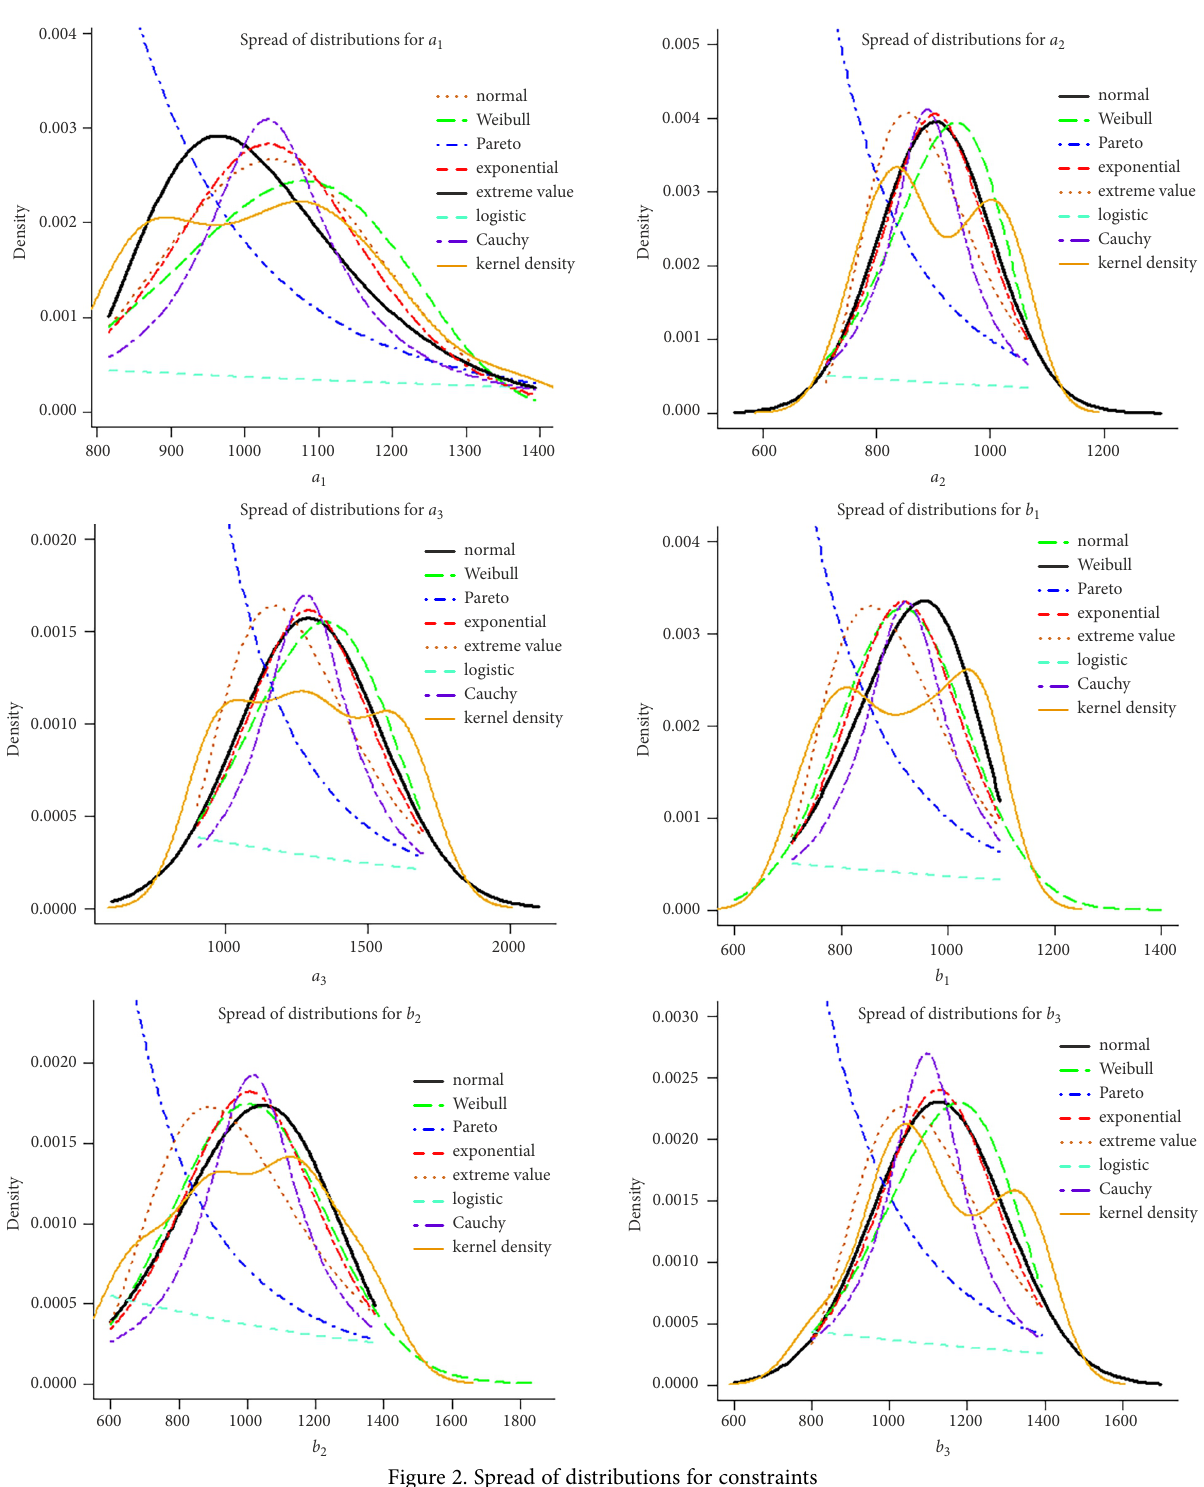
Figure 2. Spread of distributions for